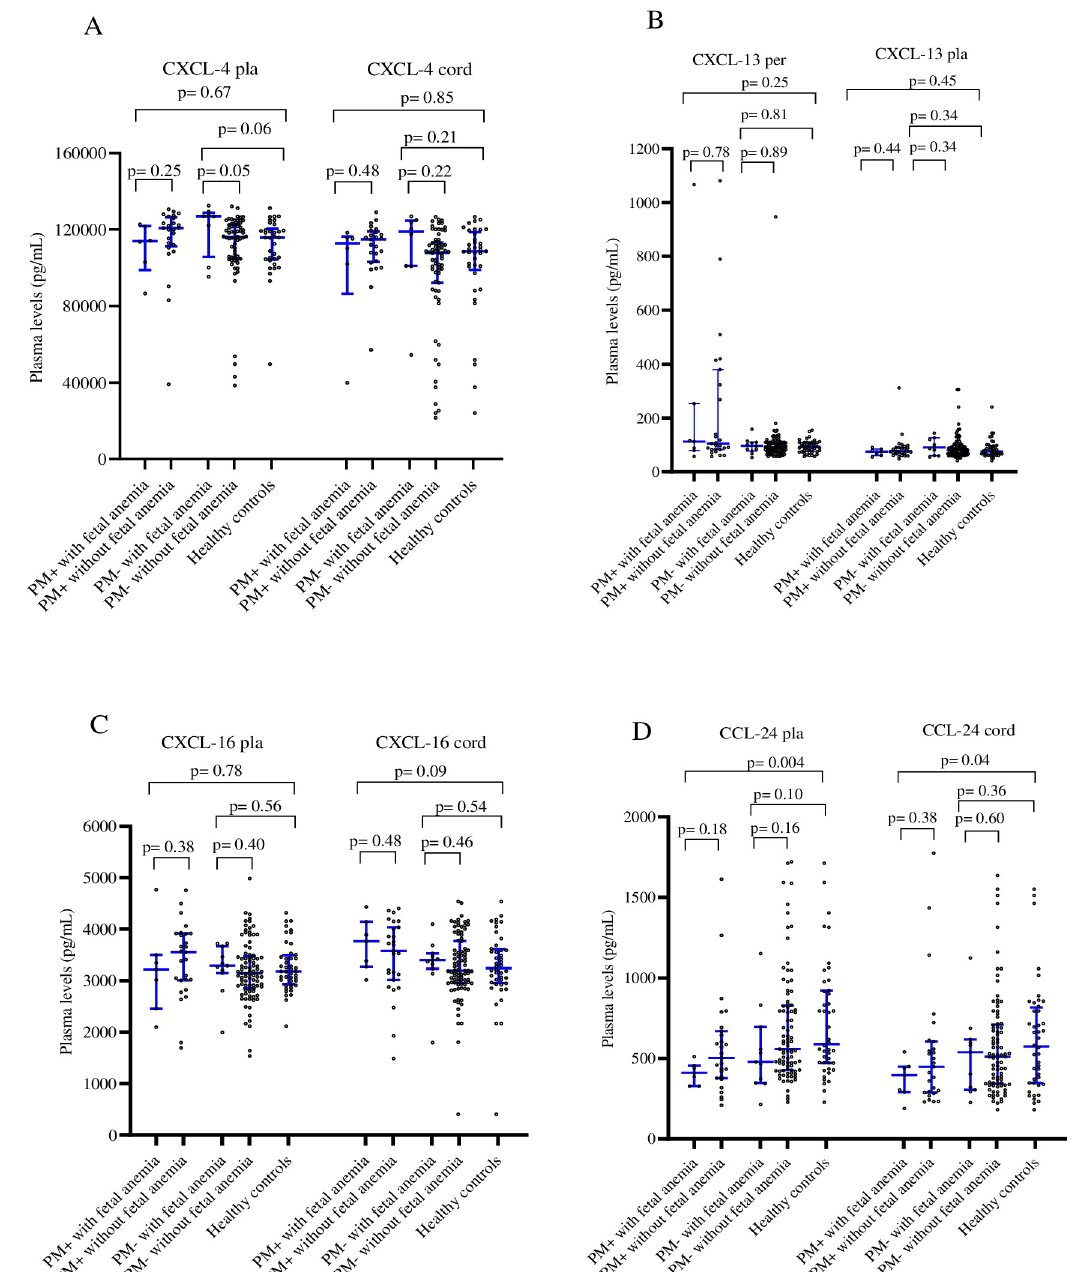
Fig 3. Plasma levels of CXCL-4, CXCL-13, CXCL-16, and CCL-24 chemokines in women at delivery in relation with fetal anemia. The levels of different chemokines in placental (Pla) and cord plasma were compared between the fetal anemia positive- group and fetal anemia negative-women group, using Mann Whitney test. PM-: Placental malaria negative-women; PM+: Placental malaria positive-women; Healthy controls: placental malaria negative women with negative peripheral blood RT-LAMP test.